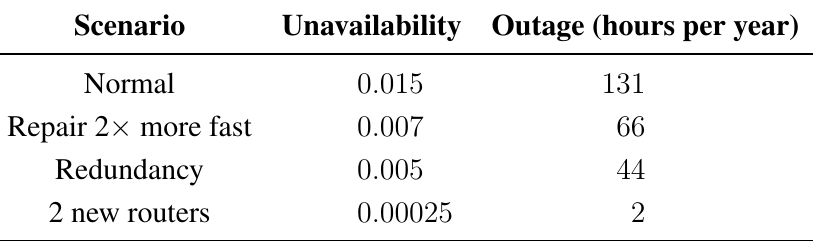
Table 2. Means to improve the availability of